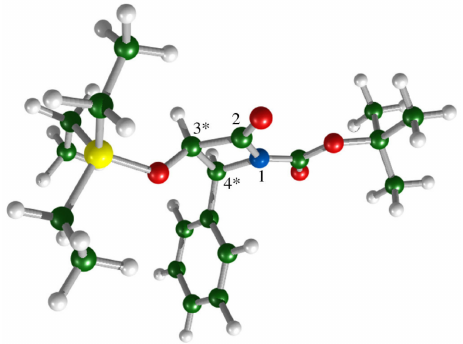
Figure 8. Structure of the (3 R ,4 S )-diastereoisomer of the 1-BOC-3-TES-4-Ph-azetidin-2-one precursor, with labeled numbering of the azetidine ring. Chiral carbon atoms are marked by asterisks. Reprinted with permission from ref. [46].Copyright 2017 American Chemical